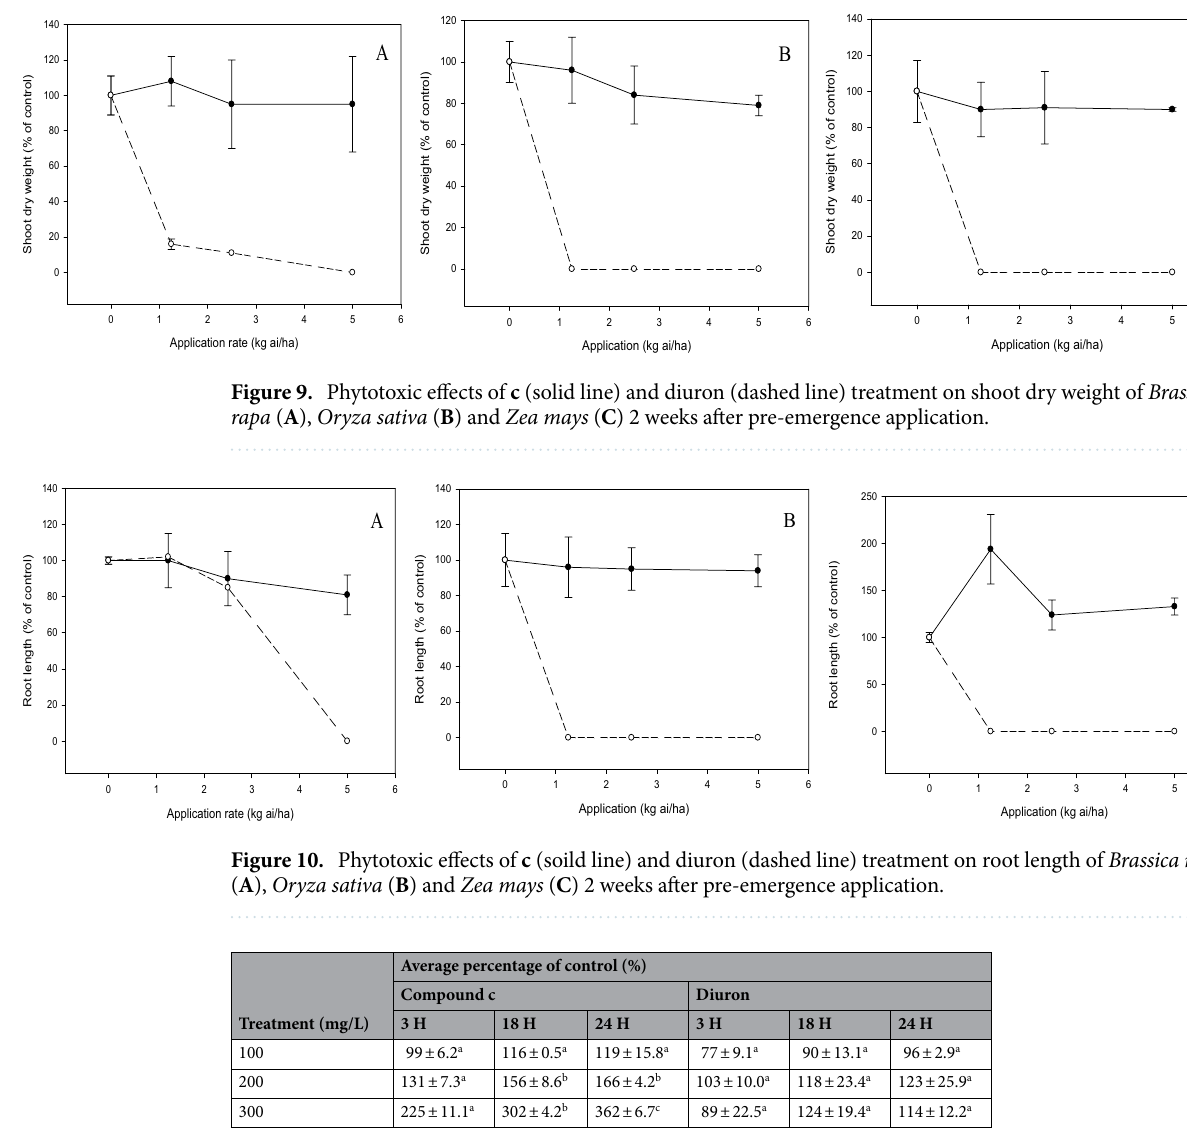
Table 3. Electrolyte leakage of Oldenlandia verticillata leaf disc after treatments of compound c and diuron. Data show the mean ± standard deviation of six replicates. *Means followed by similar small letters within the same row have no significant differences ( p > 0.05) among incubation periods within compound c or diuron.